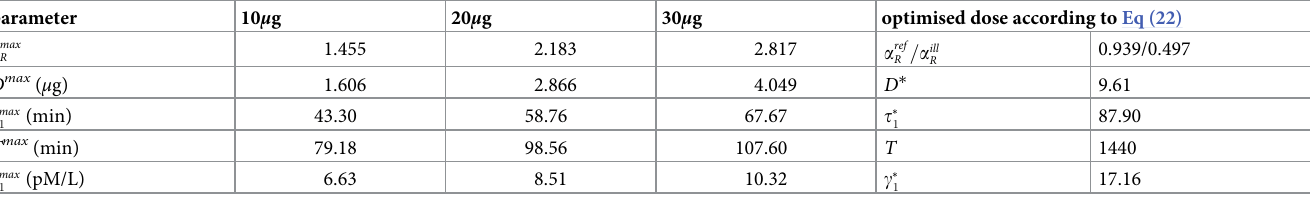
Maximum cellular responsiveness for PTH doses administered via sc daily injections given to a patient with osteoporosis. Model 2 is used for optimisation. Superscript by keeping the daily drug dose, i.e. the area A inj unchanged. Superscript * denotes the optimal max denotes values leading to maximum cellular responsiveness a max R values to reach the reference cellular responsiveness a ref . R